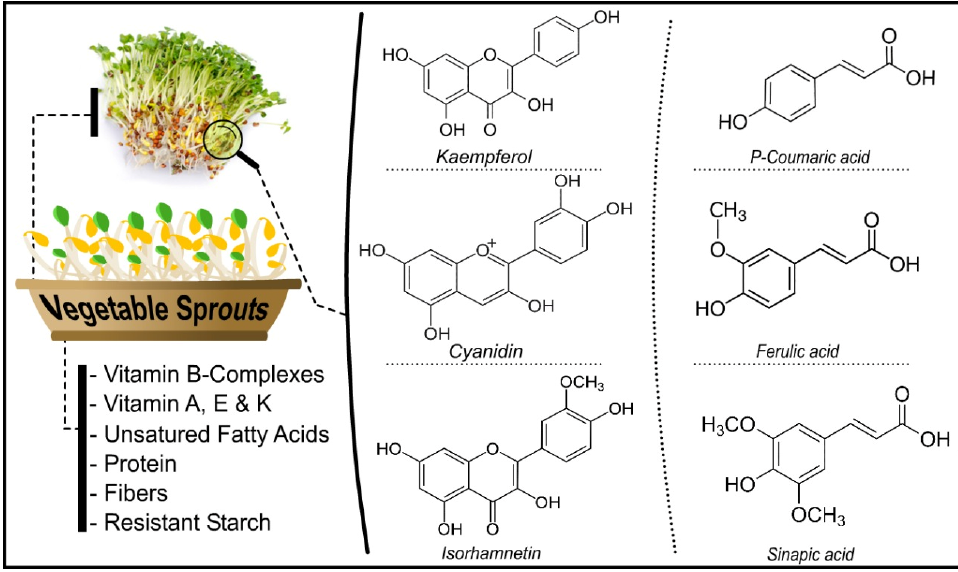
Figure 1. Different bioactive compounds in vegetables sprouts.